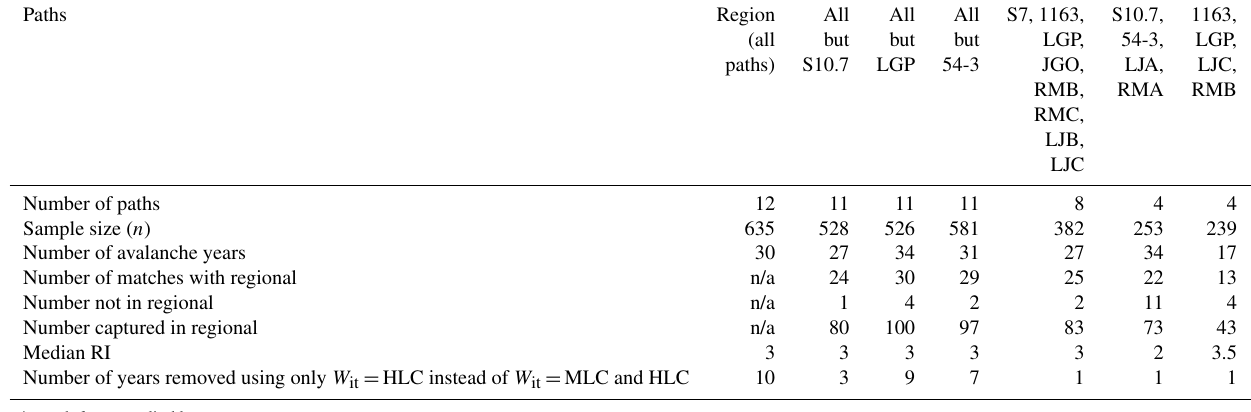
Table 6. Comparison of the number of avalanche years and return intervals (RIs) when including all 12 paths in the region to using a combination of fewer paths to define the region. HLC signifies a high level of confidence and MLC a medium level of confidence as per Favillier et al. (2017, 2018). “Number not in regional” refers to avalanche years identified in that particular combination of paths but not identified in the regional record.